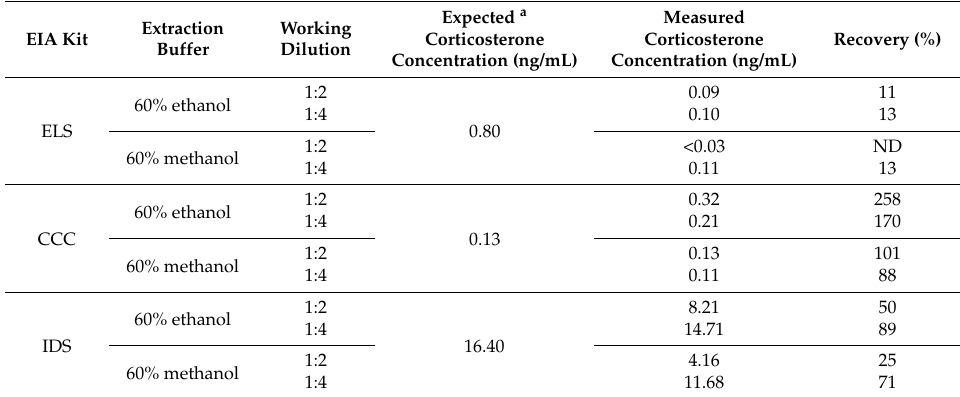
Table 4. Recovery of corticosterone from spiked blank extract in both extraction buffers in each tested commercial kit.